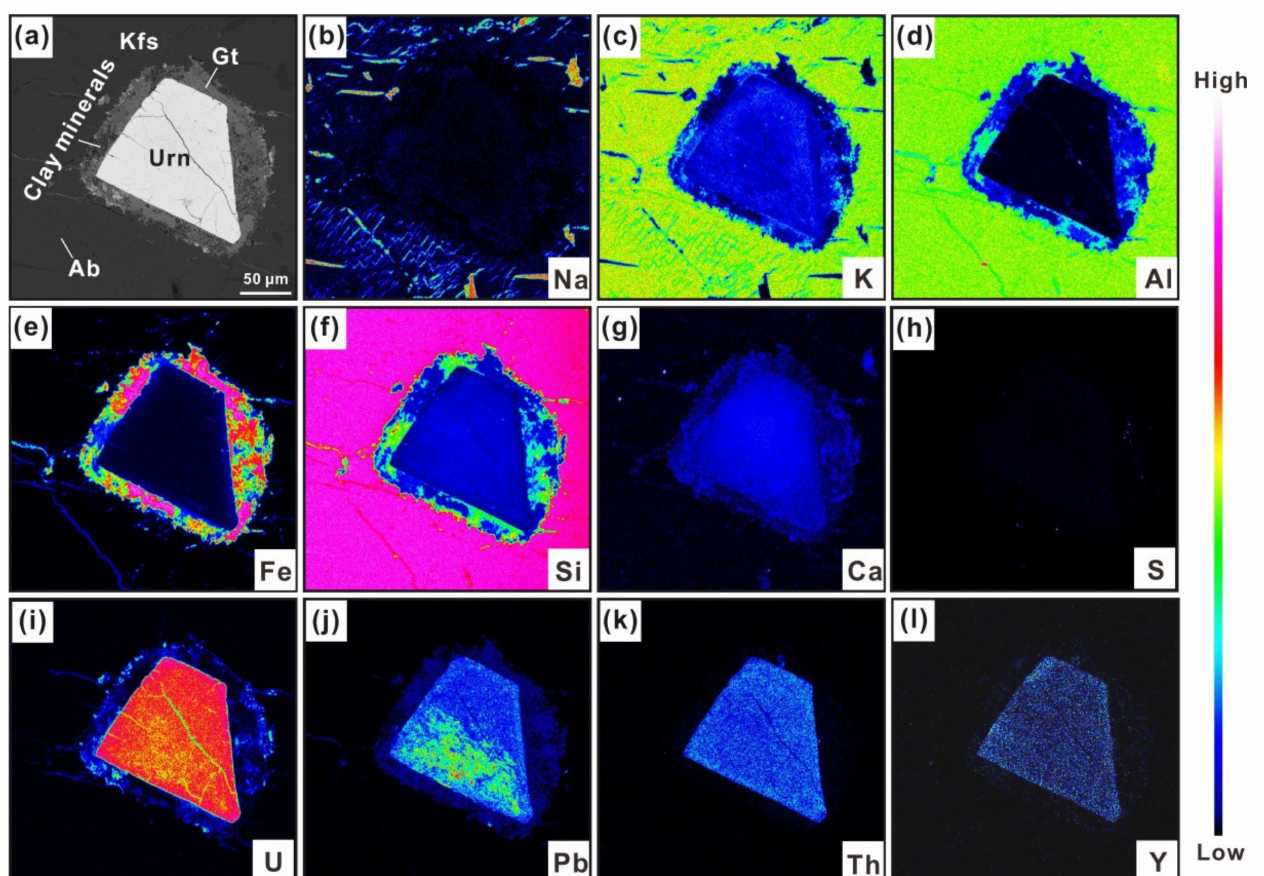
Figure 8. ( a ) Backscattered electron image showing the radiohalo and veinlets extending outwards from an altered uraninite grain. ( b – l ) X-ray compositional maps of Na, K, Al, Fe, Si, Ca, S, U, Pb, Th and Y in the same area as ( a ). Of note, Pb and U show heterogeneous redistribution within and outside the uraninite. Abbreviations: Ab—albite,